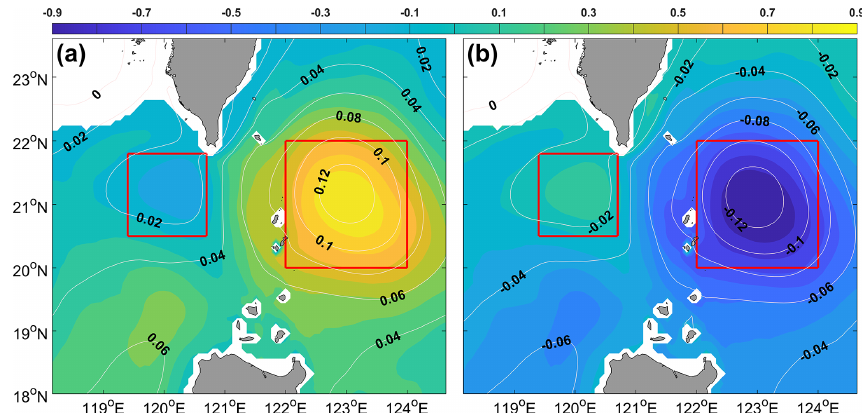
Figure 2. Spatial distribution of counter-rotating eddy pair in the LS. Spatial patterns of AE (a) and CE (b) modes. Panel (a) corresponds to average state when an AE (and b when a CE) occurred in area marked by red box on east side of LS from 1993 to 2020. Contours represent SSHA (units of m). Colors represent sea temperature anomaly (units of ◦ C) at a depth of 300m. Interval of SSHA is 0.03m. Red boxes on west and east sides of LS border mark 20.5–21.8 ◦ N, 119.4–120.7 ◦ E and 20–22 ◦ N, and 122–124 ◦ E, respectively. Figure is similar to Fig. 3 of Sun et al. (2018), and is based on HYCOM